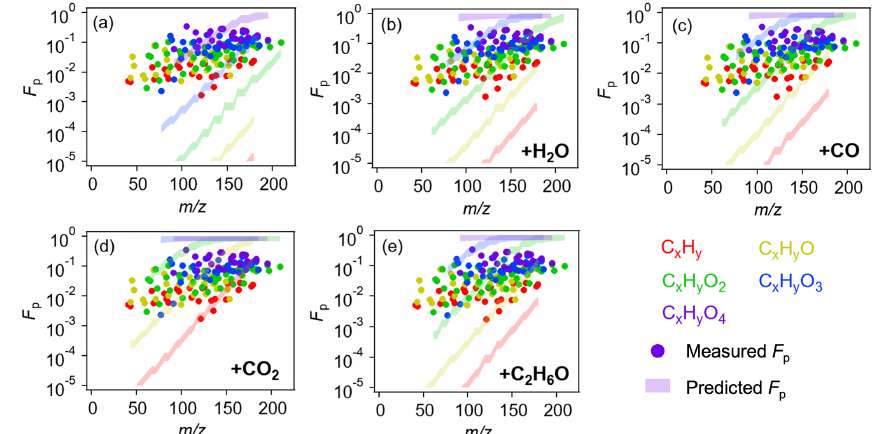
Figure 5. (a) Campaign average fraction of organic species in the particle phase ( F p ) grouped by oxygen number. Solid markers represent the calculated F p based on the CHARON–PTR-ToF-MS measurements. Colored shading represents the predicted F p of corresponding molecular formulas. (b–e) Measured vs. predicted F p , assuming the identified species are fragments of corresponding parent compounds through neutral losses of H 2 O, CO, CO 2 , and C 2 H 6 O, respectively (values are given in Table